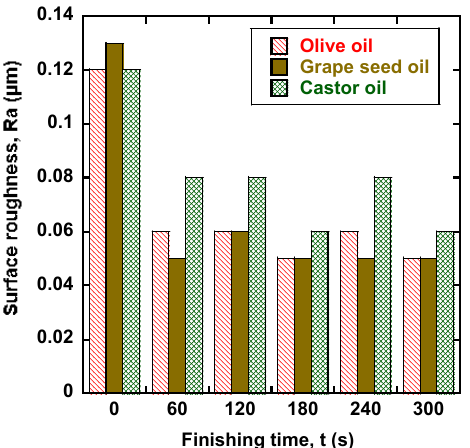
Figure 7. Surface roughness (Ra) vs. finishing time according to the oil used (2000 rpm).